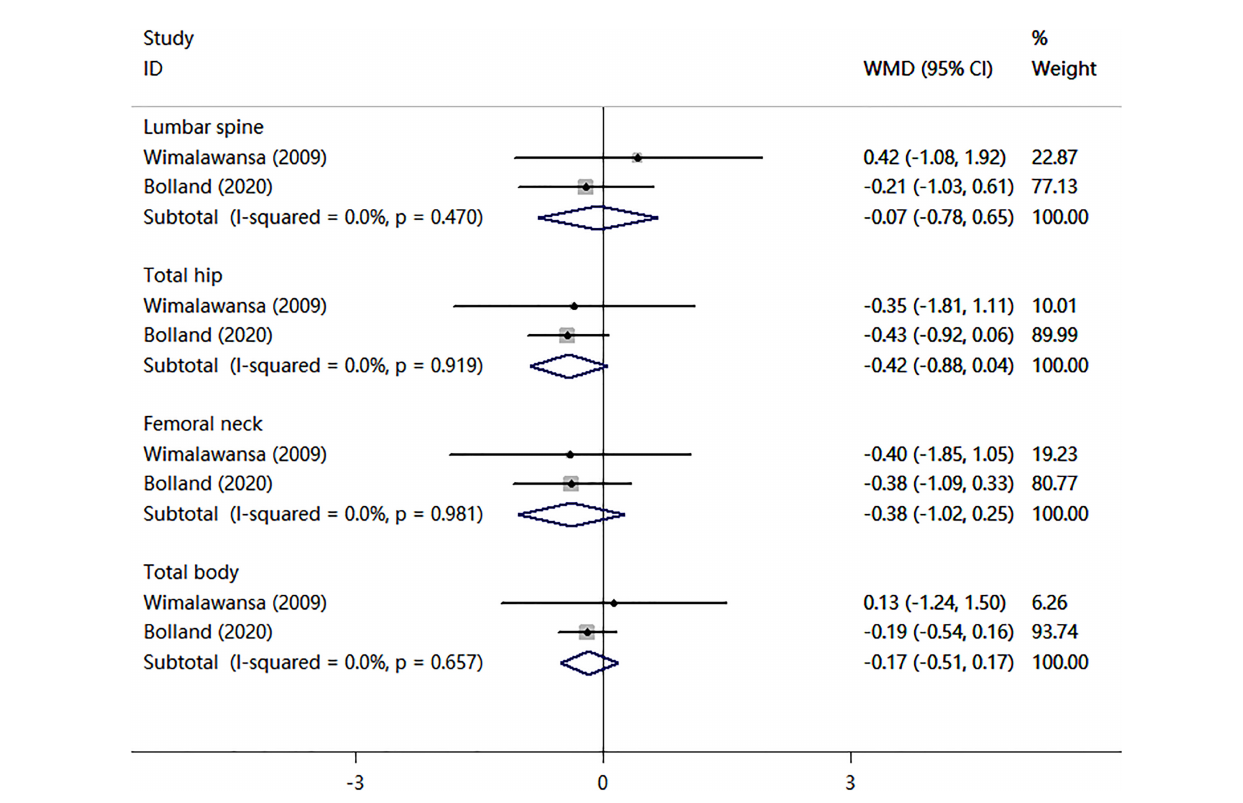
FIGURE 3 | Meta-analysis of the effects of nitrates on BMD compared with placebo.